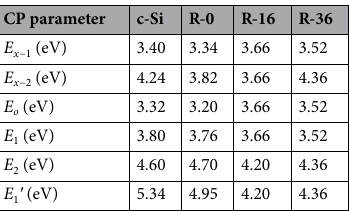
Table 2. Critical-point (CP) parameters used in the calculation of second derivatives.